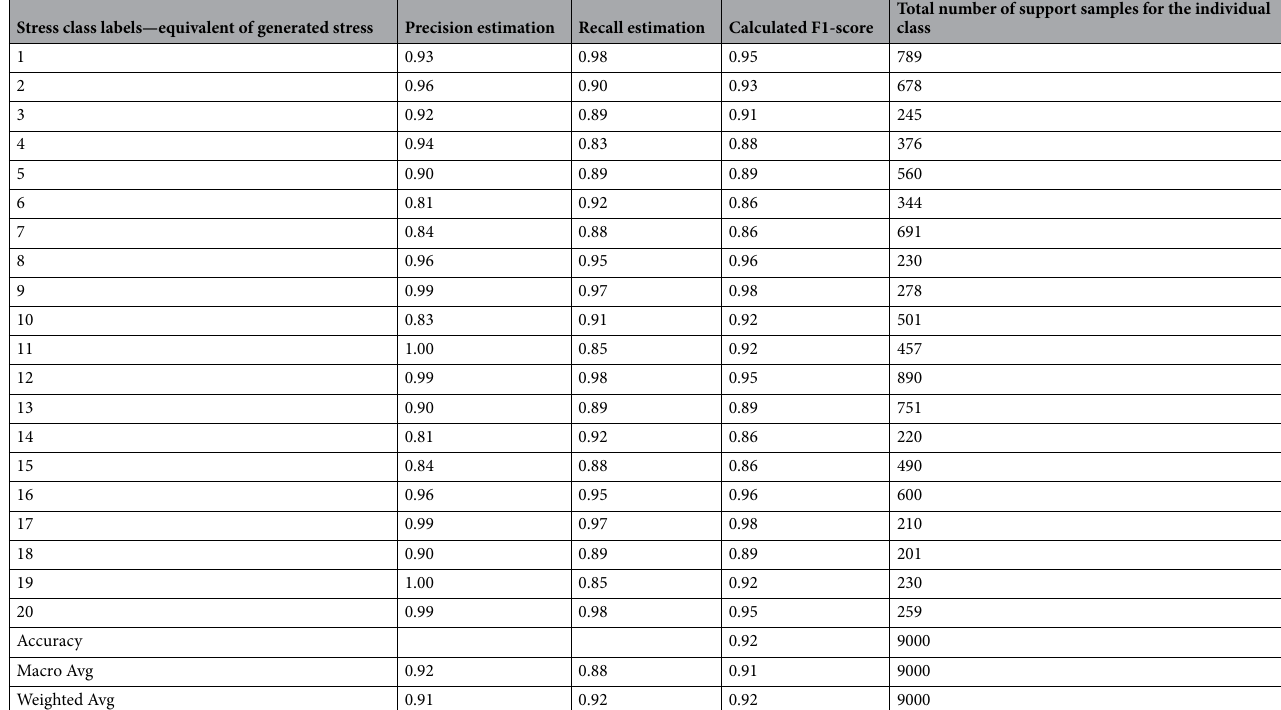
Table 3. The complete classification report for the RF based multiclass classification results including prediction accuracy, precision, recall, F1-score of classification results from the independent validation stage while predicting class labels related to the classes of